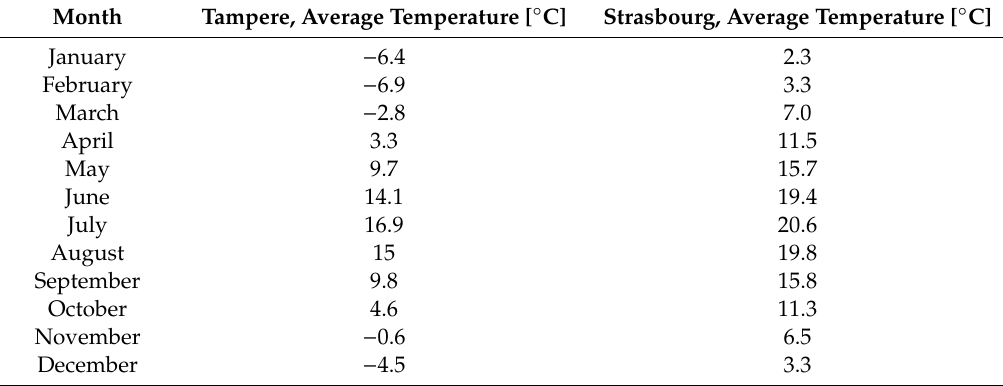
Table 2. The monthly average outdoor temperatures used in the exergy analysis.